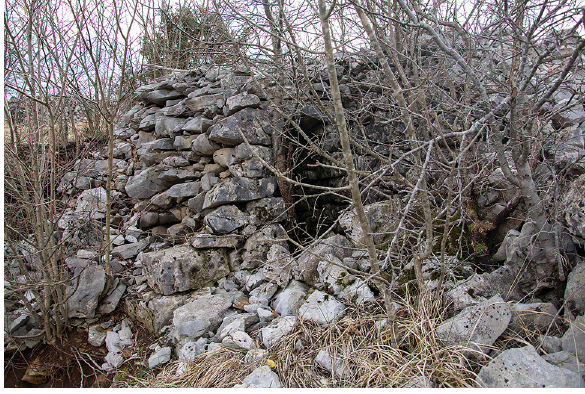
Figure 1. Most shelters are rather small and hidden (HIS_033).